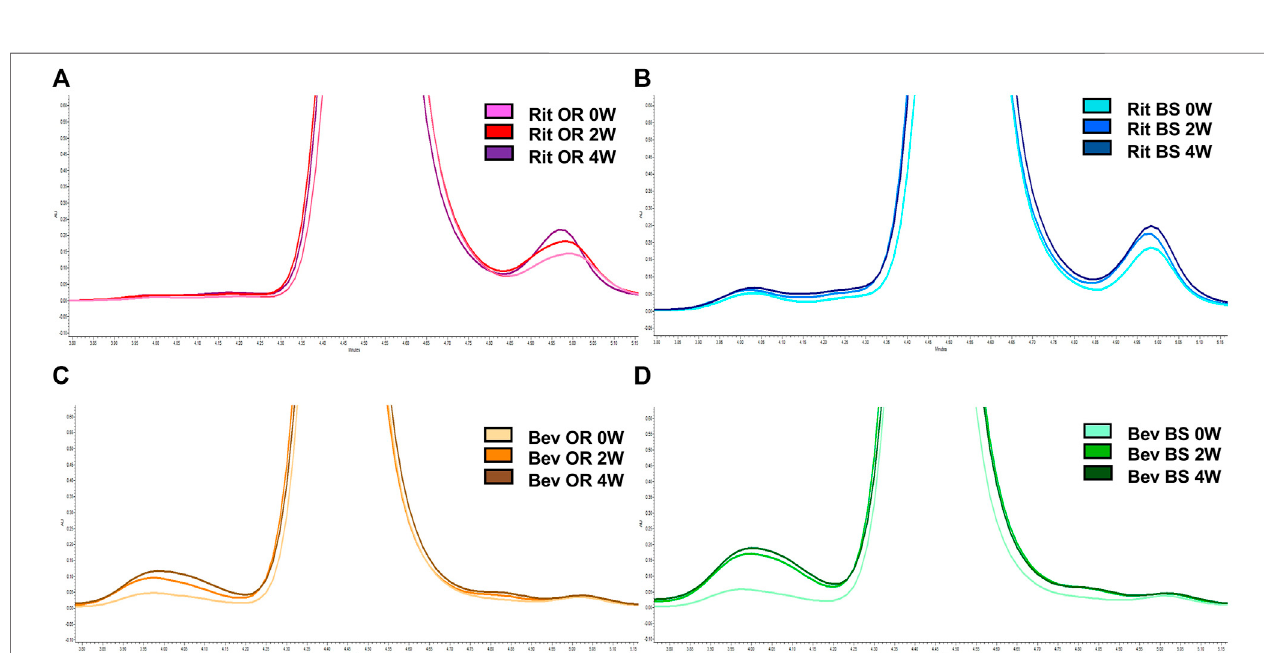
FIGURE5| RepresentativeSECchromatogramsat214 nmfor15 µgofantibody. (A) RituximabORat0(pink),2(red)and 4(purple)weeks; (B) RituximabBSat0 (light blue), 2 (blue) and 4 (navy) weeks; (C) Bevacizumab OR at 0 (peach), 2 (orange), and 4 (brown) weeks; (D) Bevacizumab BS at 0 (teal), 2 (green) and 4 (dark green) weeks. Stressed samples were shaking at 240 RPM, incubating at 37 ° C for 2 or 4 weeks. Chromatograms are zoomed in to depict the increase in aggregates and/or fragments detected in each sample across each timepoint.